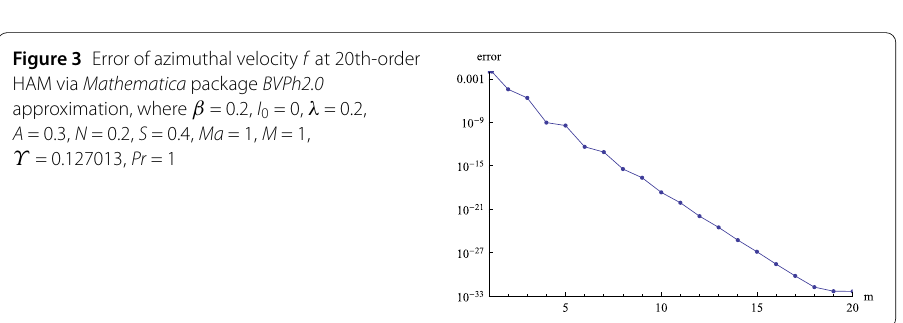
Figure 2 Maximum average squared residual error at different orders of approximation, where λ = 0.2, A = 0.3, N = 0.2, S = 0.4, Ma = 1, M = 1, Υ = 0.127013, Pr = 1, I 0 = 0, and β = 0.2